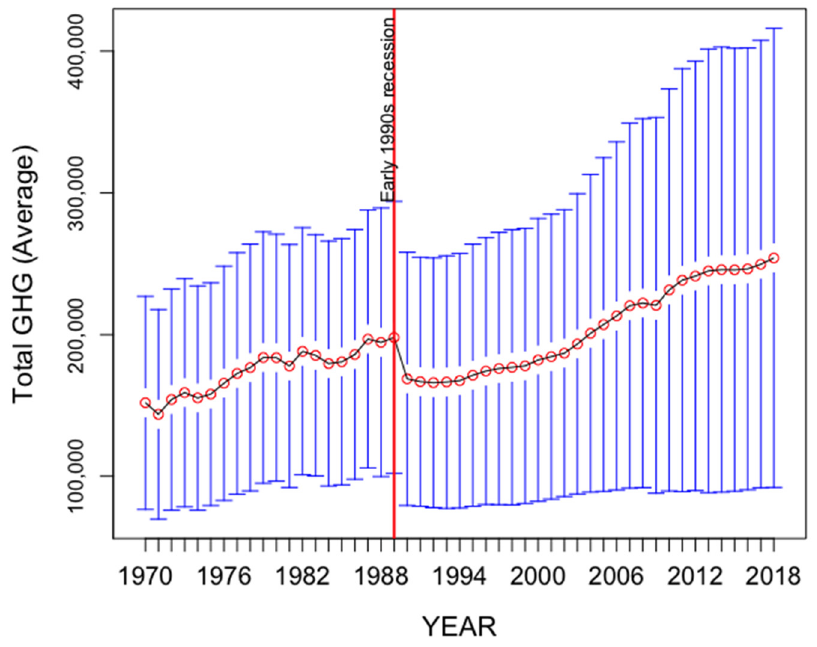
Figure 1. Historical trend of mean GHG emissions in 175 countries (1970–2018).